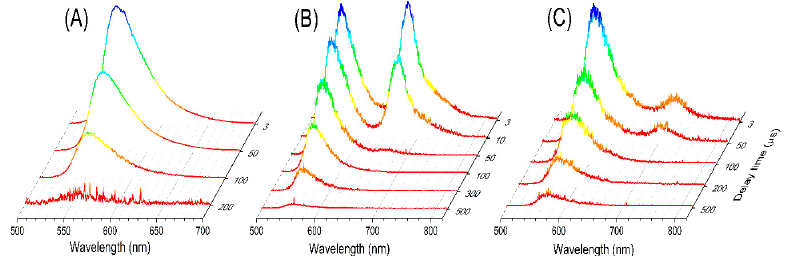
Figure 3. Time-dependent emission spectra of PM567 in ethyl acetate ( A ) and in n -propyl iodide ( B ), and PM597 in n -propyl iodide ( C ) recorded under ambient conditions after laser photo-excitation at 532 nm. Optically matched solutions were used.